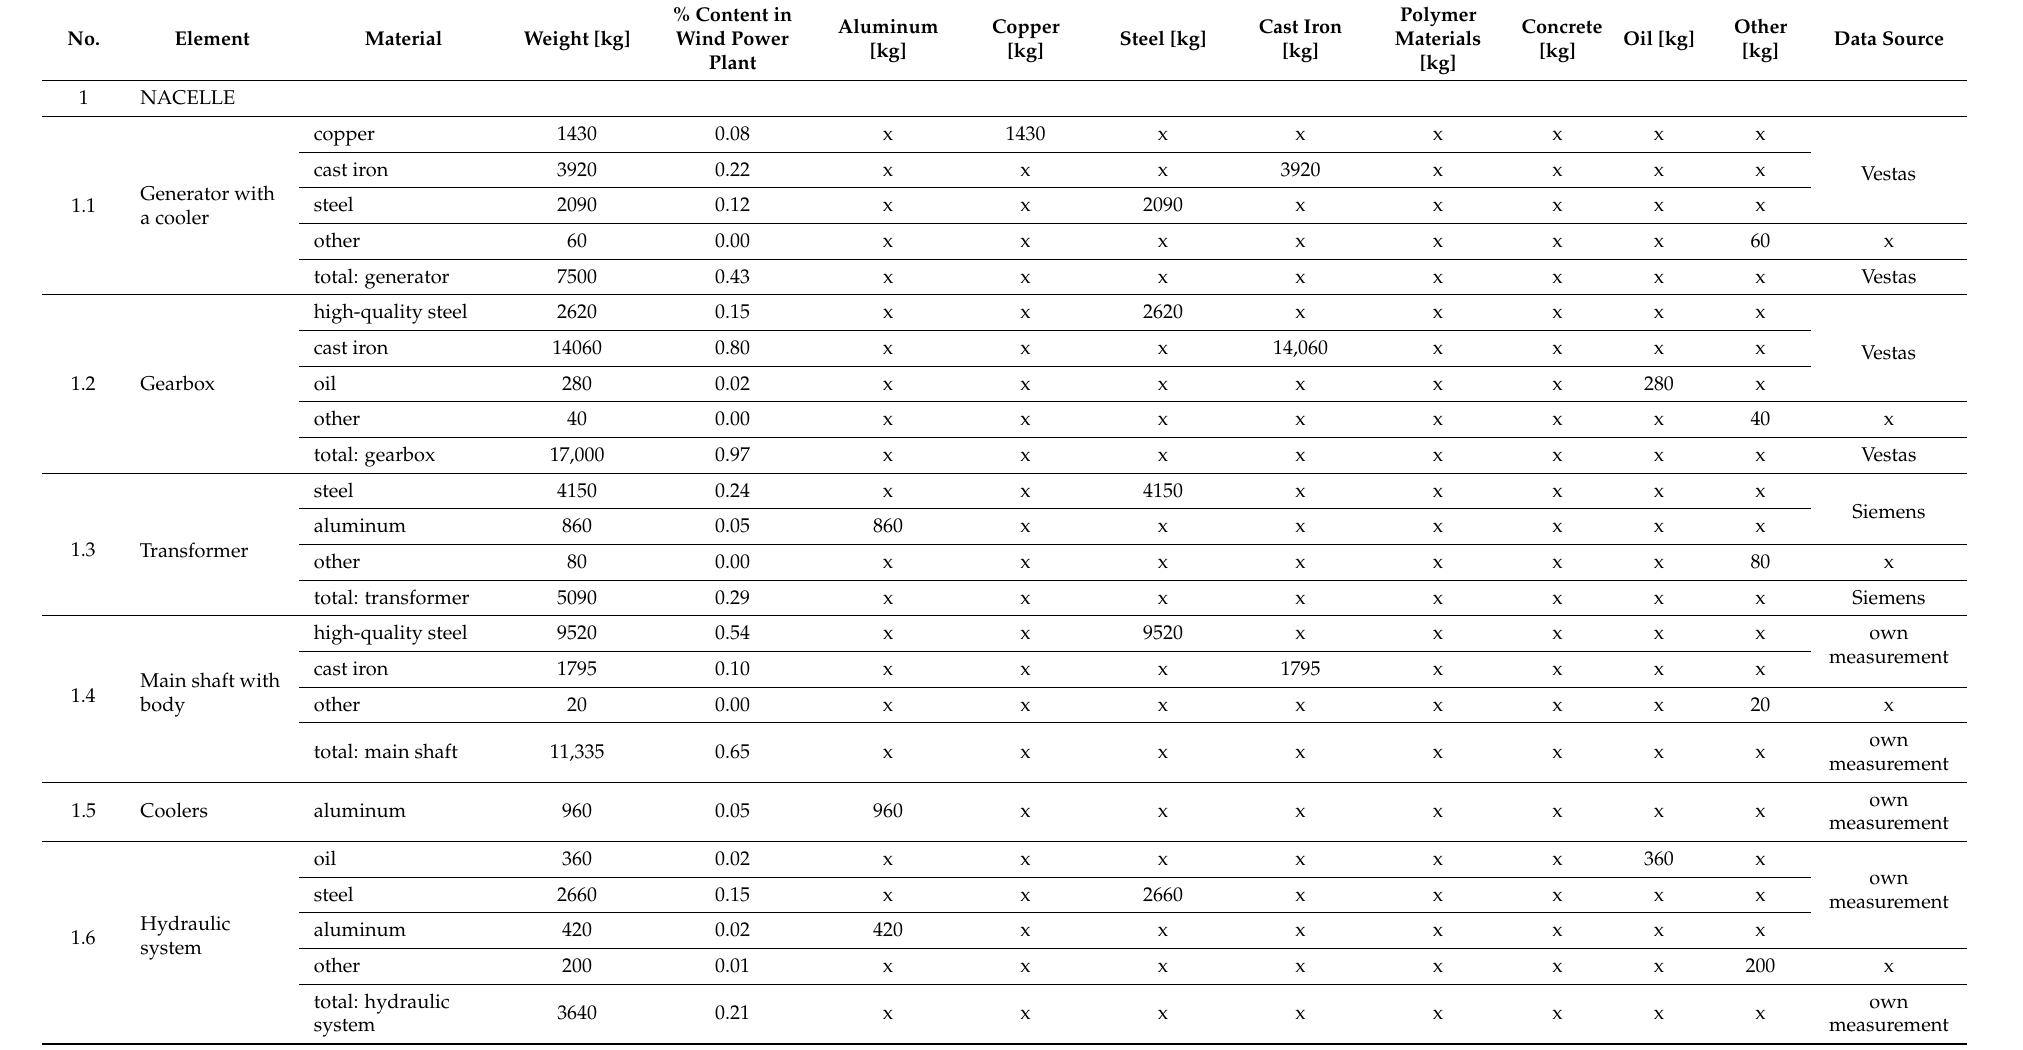
Table 1. Register of materials for the production of the Vestas V90/105 m wind power plant [own